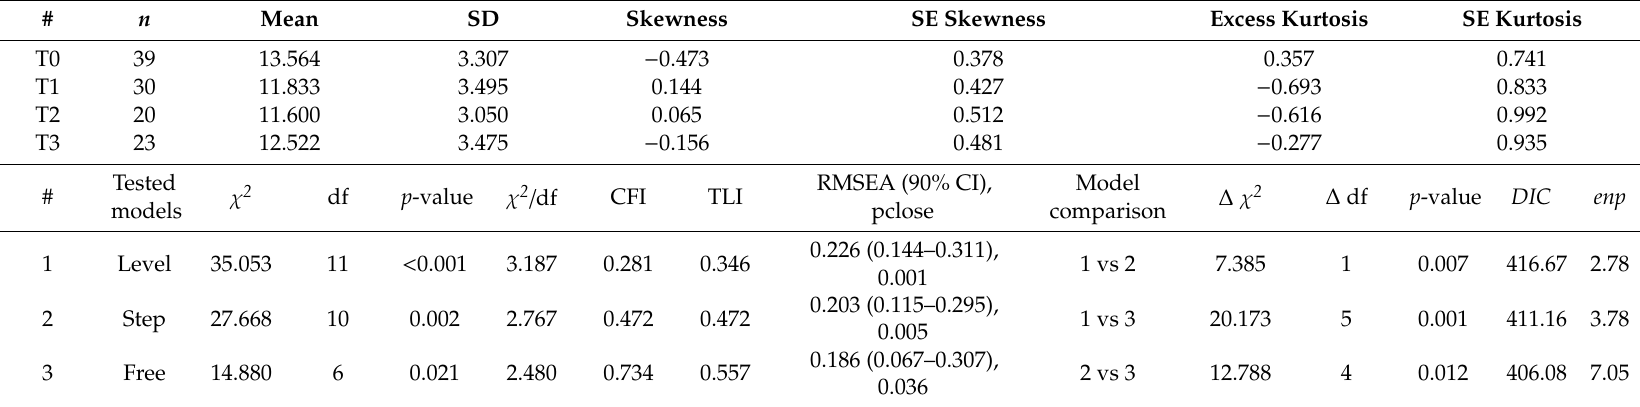
Table 1. Comparisons of latent growth curve models estimating growth trajectory for a cyclical representation of PD over an 18-month follow-up